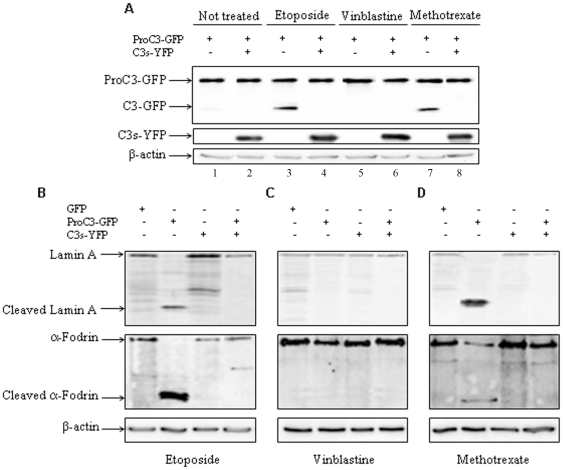
Caspase-3s prevents procaspase-3 activation.
A. MCF-7 cells stably transfected with caspase-3 were treated with etoposide, vinblastine or methotrexate (lanes 1, 3, 5 and 7). Caspase-3 was cleaved in procaspase-3 transfected cells after 48 hour treatment with etoposide, or methotrexate but not after vinblastine treatment. In procaspase-3-GFP/C3s-YFP co-transfected treated MCF-7 cells (lanes 2, 4, 6, and 8), procaspase-3 cleavage was completely abolished. β-actin was used as loading control. B–D. Analysis of lamin-A and α-fodrin cleavage by Western Blot. GFP MCF-7 cells, procaspase-3-GFP (ProC3-GFP) or caspase-3s-YFP (C3s-YFP) transfected cells were treated with etoposide (B), vinblastine (C) or Methotrexate (D) during 48 hours. Lamin-A and α-fodrin were cleaved only in single procaspase-3-GFP transfected cells treated with etoposide or Methotrexate. ProC3-GFP/C3s-YFP co-transfected cells treated with etoposide or methotrexate did not show cleavage of neither lamin-A nor α-fodrin. In accordance with panel A, vinblastine did not induce cleavage of neither lamin-A nor α-fodrin β-actin was used as loading control.